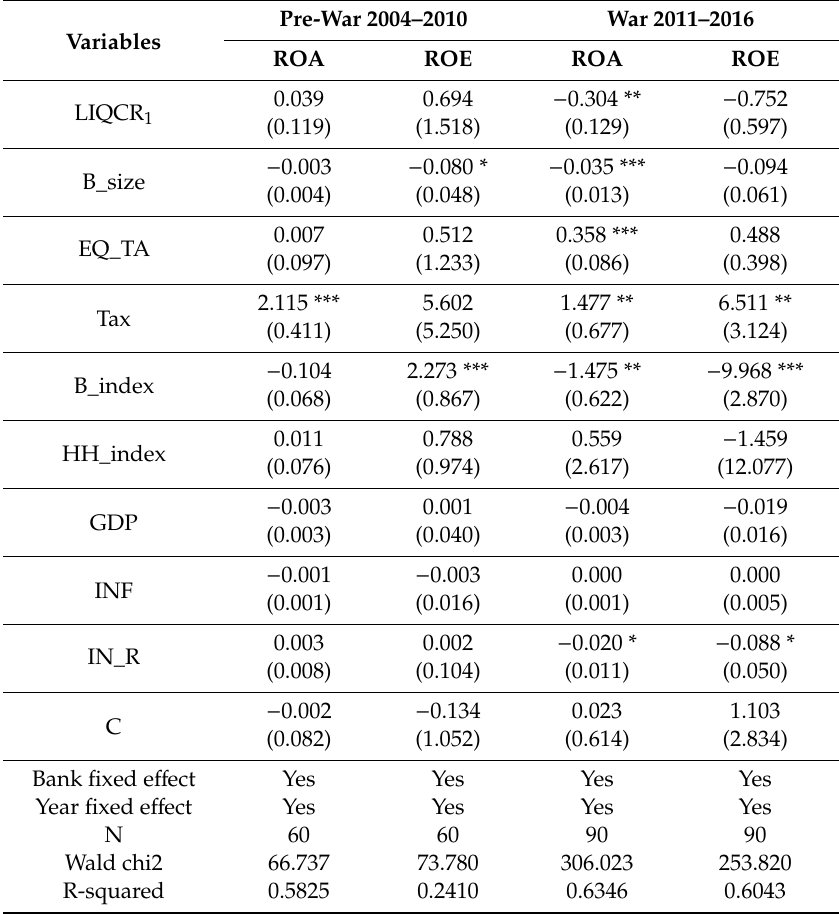
Table 8. The relationship between liquidity creation and bank performance in both